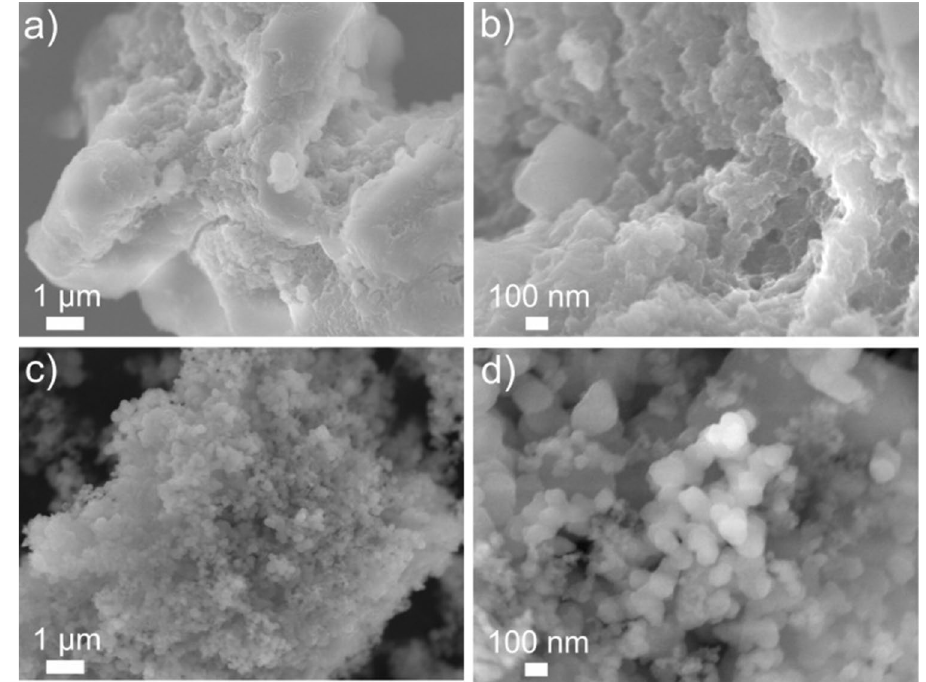
Figure 4. Low and high magnification SEM images of (a, b) 2-chloro-2-propen-1-ol, and (c, d) ethylene